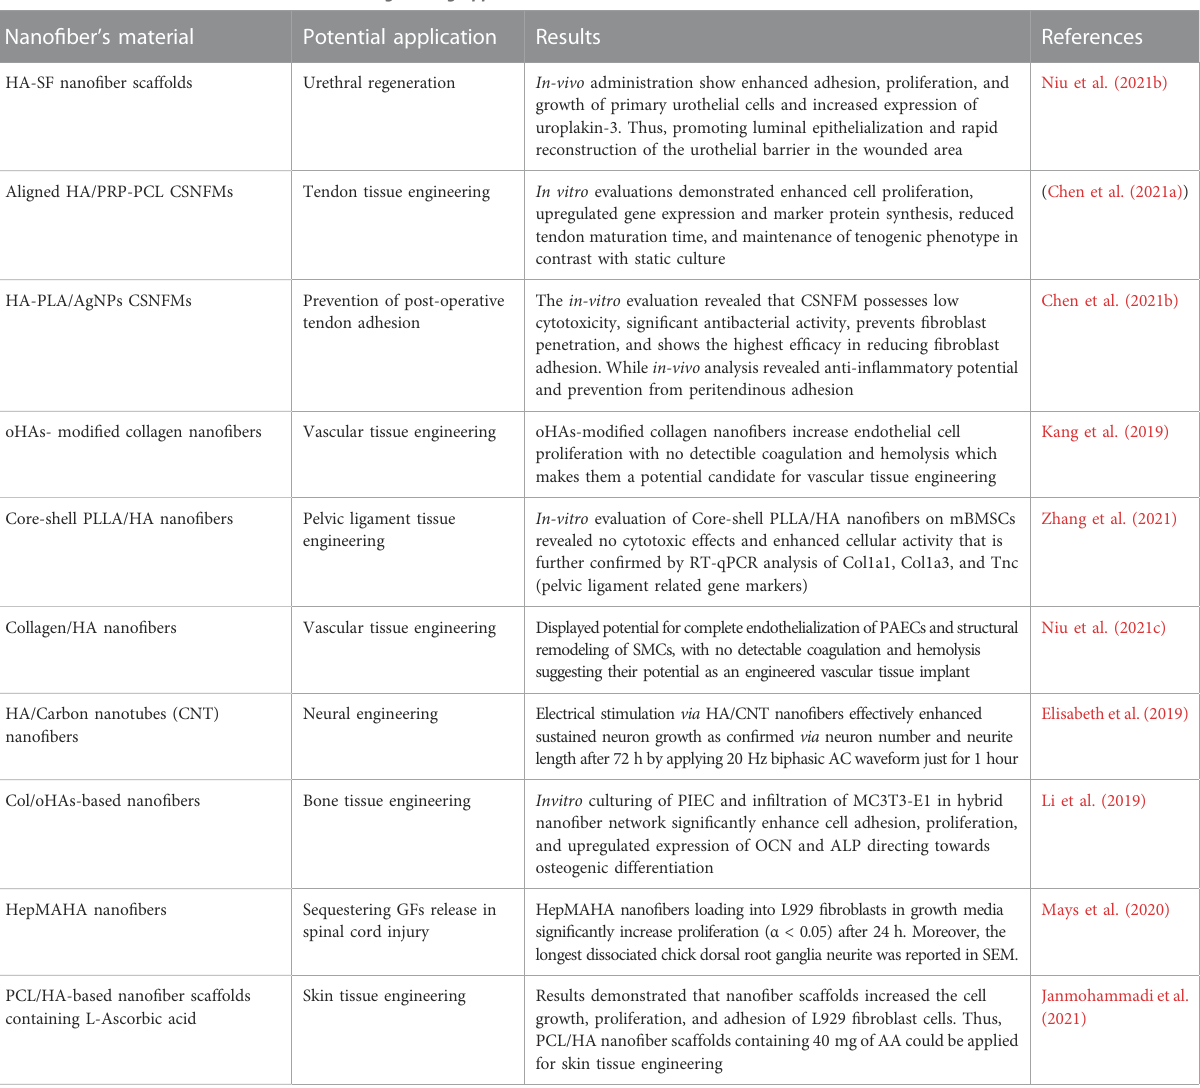
TABLE 2 HA-derived nano fi bers and their tissue engineering applications